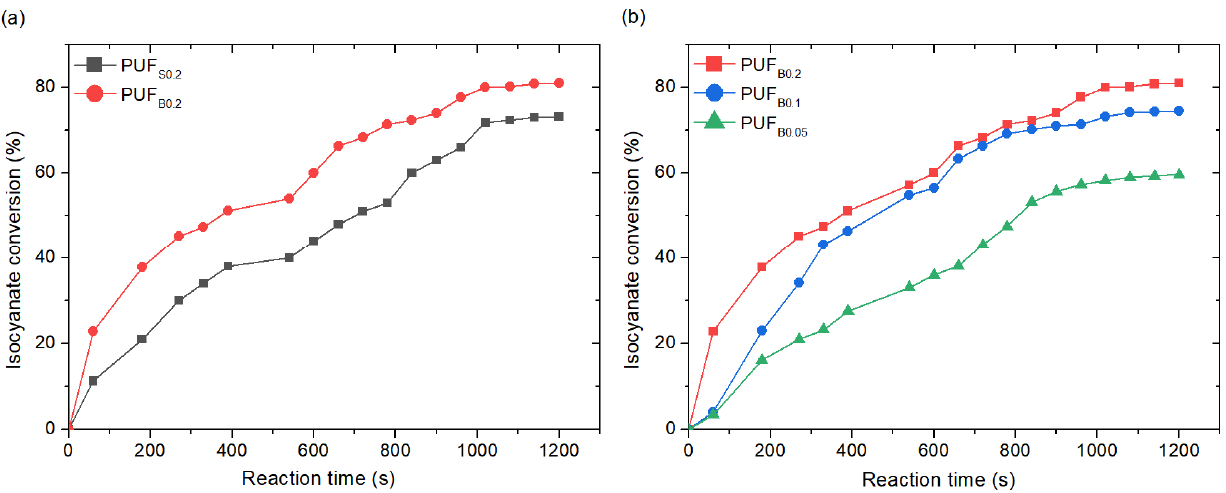
Figure 3. Isocyanate conversion with ( a ) similar concentrations of bismuth triflate and stannous octoate; ( b ) different concentrations of bismuth triflate.